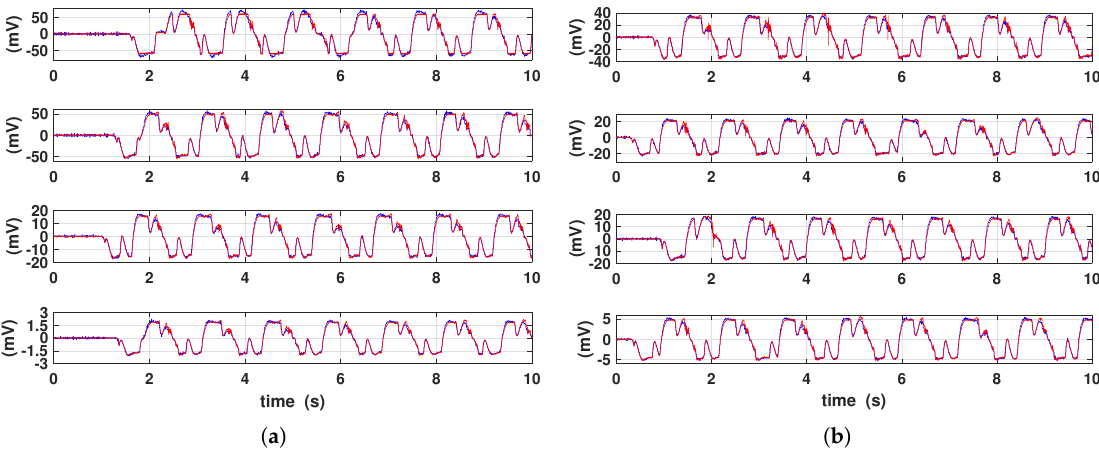
Figure 10. Measured (color red) and simulated (color blue) output voltages. 15 mm diameter PM and 150 mm/min strain velocity are applied. ( a ) Coils connected in series on 10 k, 525, 100 and 10 Ω (from top to bottom pane). ( b ) Coils connected in parallel on 10 k, 100, 58 and 10 Ω (from top to bottom